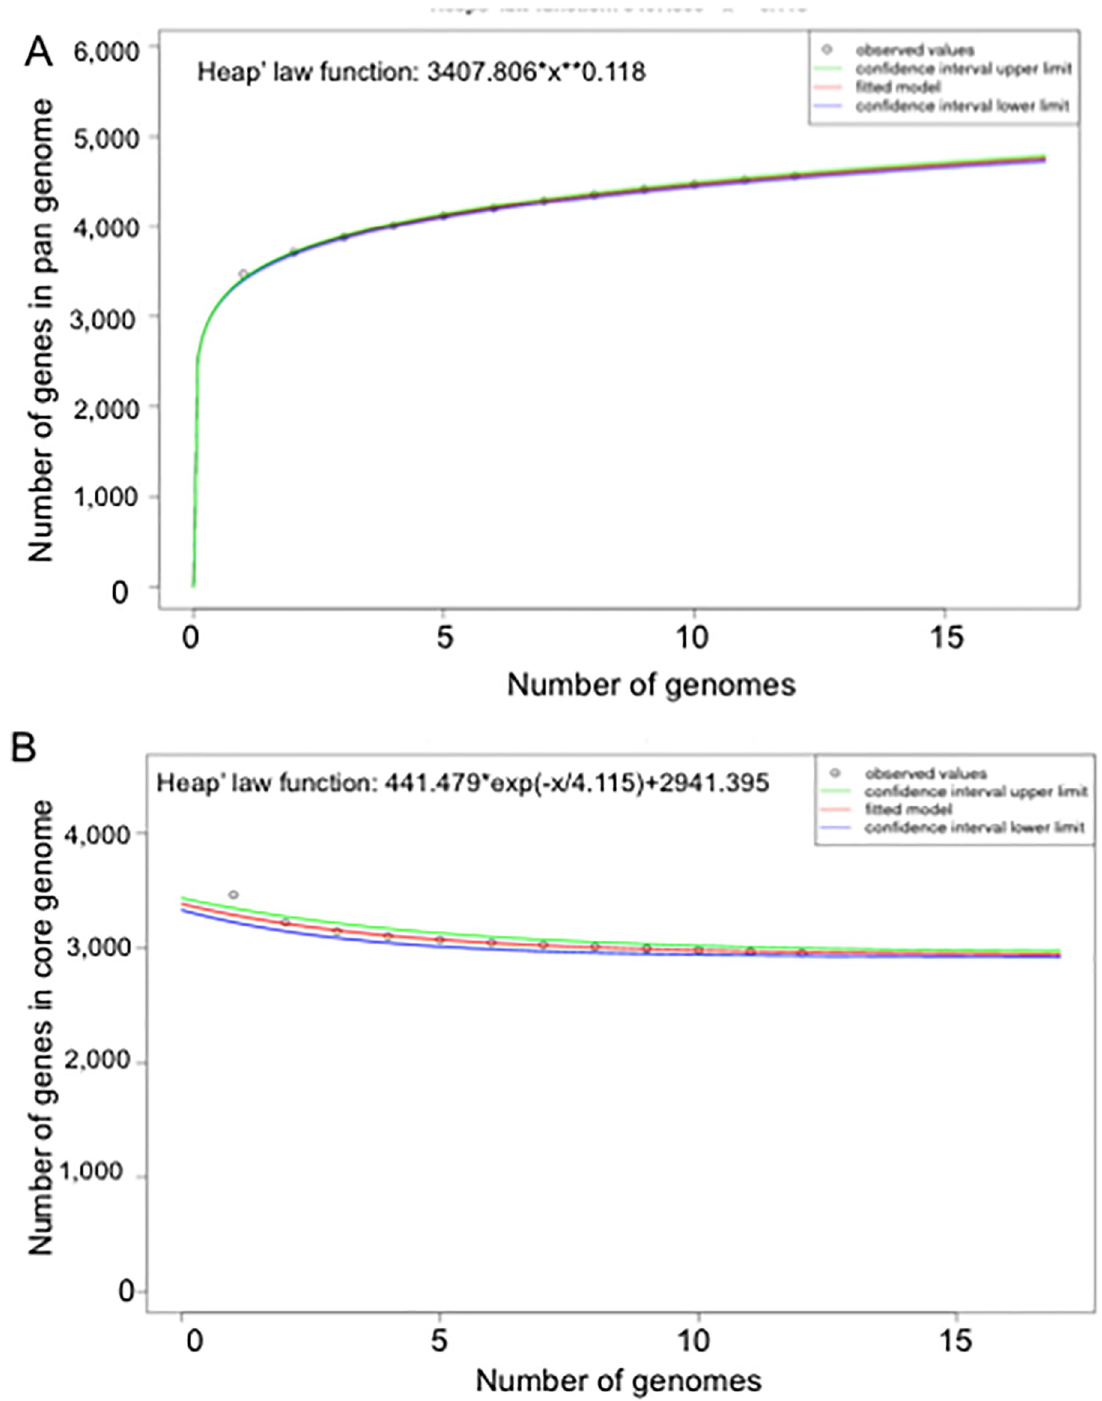
Fig 1. Pan, core, and singleton genome evolution according to the number of selected Elizabethkingia genomes. (A) Number of genes (pan-genome) for a given number of genomes sequentially added. The pan development plot was generated for the following genomes: E . meningoseptica EM2 (NZ_MDTZ01000014), E . meningoseptica NV2016 (NZ_FRFB01000021), E . meningoseptica G4120 (NZ_CP01 6378), E . meningoseptica CSID3000516359 (NZ_MAHC01000017), E . meningoseptica CCUG214 (NZ_FLSV01000010), E . meningoseptica CSID_3000515919 (NZ_MAGZ01000024), E . meningoseptica CSID_3000516535 (NZ_MAHF01000020), E . meningoseptica ATCC13253 (NBRC_12535), E . meningoseptica EM3 (NZ_MDTY01000011), E . meningoseptica CIP111048 (NZ_FTPF01000022), E . meningoseptica 61421PRCM (NZ_MPOG01000010), E . meningoseptica EM1 (NZ_MCJH01000010), E . meningoseptica 58_80 (NZ_FTRA01000043). (B)